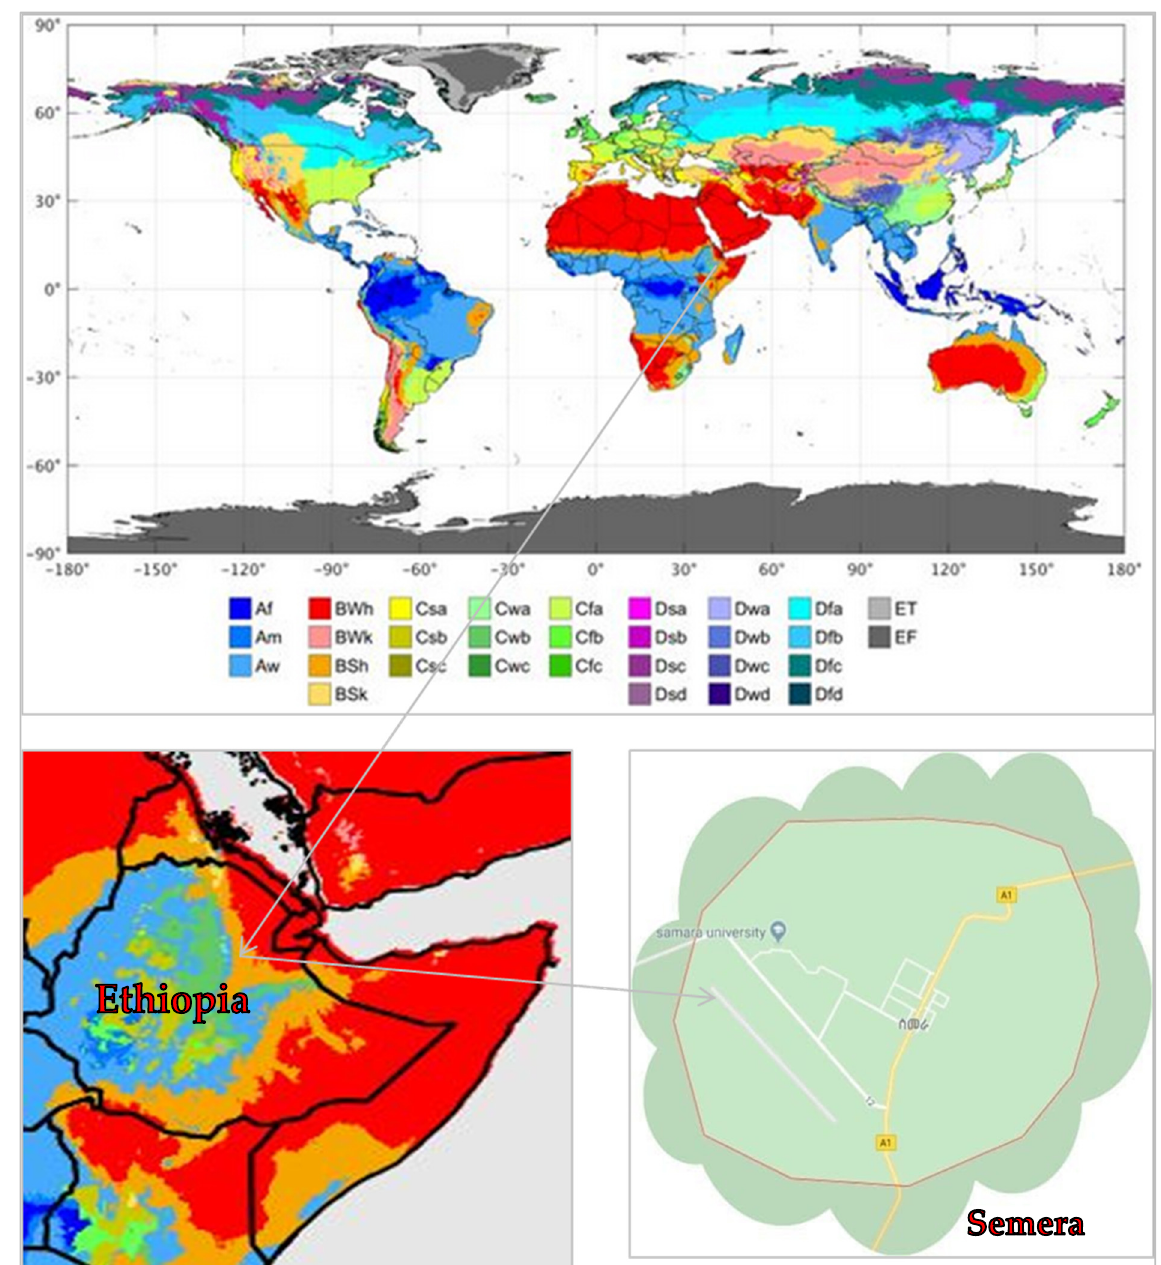
Figure 3. Climate map of the study area based on the Köppen climate classification.